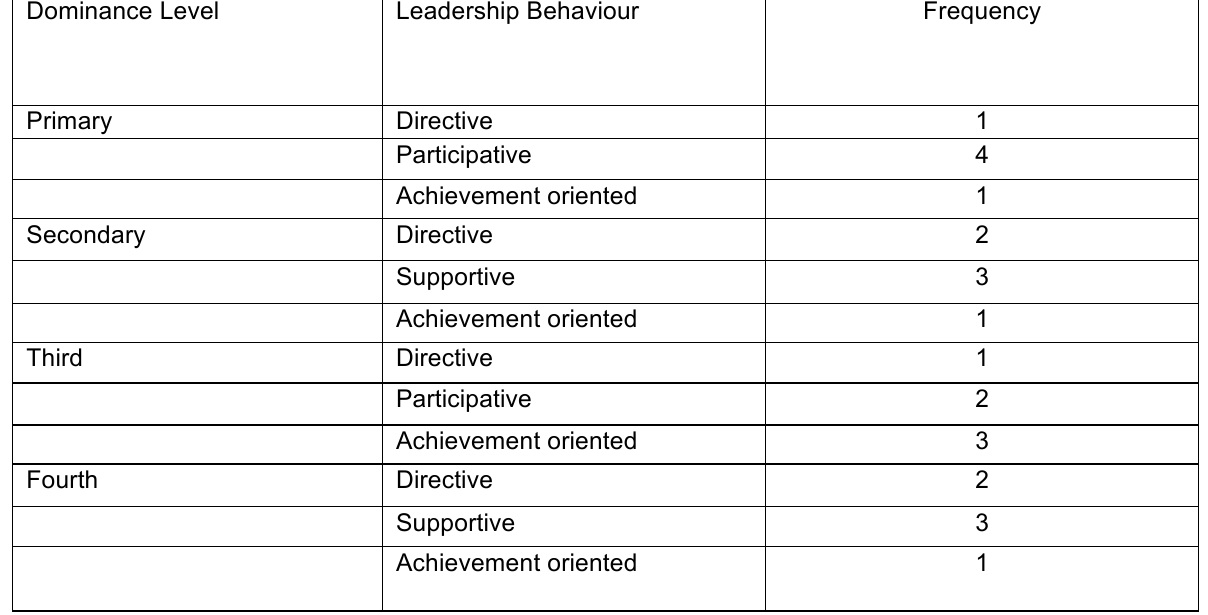
Table 3: Frequency Distribution of Leadership Behaviours